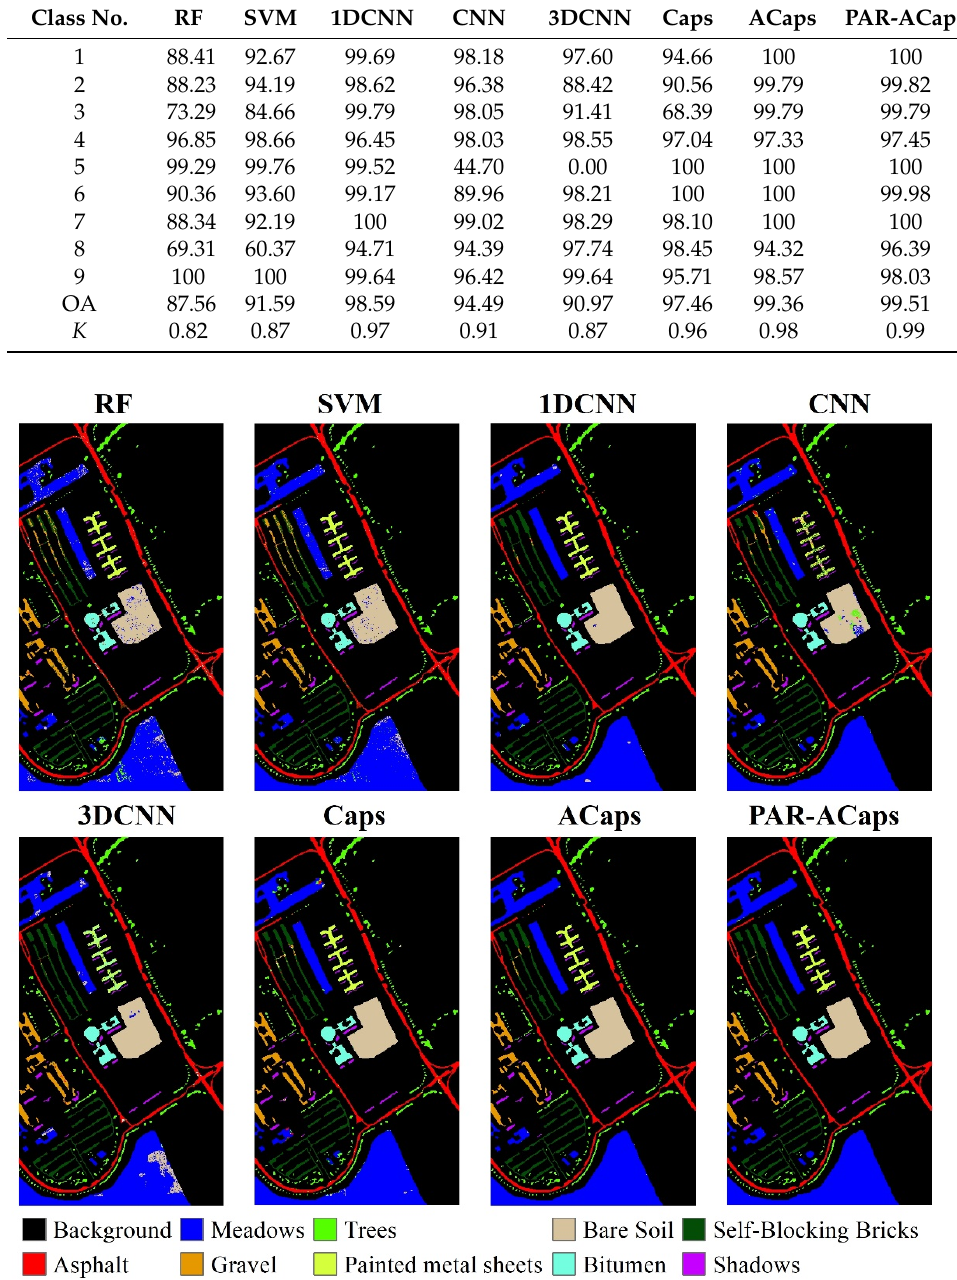
Figure 8. The classification results of PU dataset obtained by the PAR-ACaps and the benchmarks. As shown in Figure 9, the OAs obtained by the RF, SVM, 1DCNN, CNN, 3DCNN, Caps, ACaps, and PAR-ACaps for SA dataset were 73.43%, 81.56%, 83.65%, 93.92%, 85.05%, 86.66%, 92.75%, and 94.52%, respectively. The OAs of the benchmarks (i.e., RF, SVM, 1DCNN, CNN, 3DCNN, Caps, and ACaps) were lower than that of PAR-ACaps. Especially for the RF, SVM, 3DCNN, and Caps, many samples of Corn_se- nesced_green_weeds were misclassified as Lettuce_romaine_6wk and Lettuce_ro- maine_7wk. Specifically, the classification accuracies obtained by RF, SVM, 3DCNN, and Caps were only 2.93%, 29.66%, 45.64%, and 69.99%, respectively, as shown in Table 4. In addition, many samples of Lettuce_romaine_4wk were misclassified as Lettuce_ro- maine_5wk by Caps, and the classification accuracy was only 79.90%, which is signifi- cantly lower than other classifiers. This led to the OAs of RF, SVM, 3DCNN, and Caps being far lower than those of CNN and PAR-ACaps. In contrast to the benchmarks, the OA of SA dataset was significantly improved by PAR-ACaps. Particularly, the classifica- tion accuracy of Corn_senesced_green_weeds was significantly improved and only lower than those of 1DCNN and CNN. Thus, the OA achieved by PAR-ACaps was the highest, and its outperformance can be clearly seen from Figure 9.